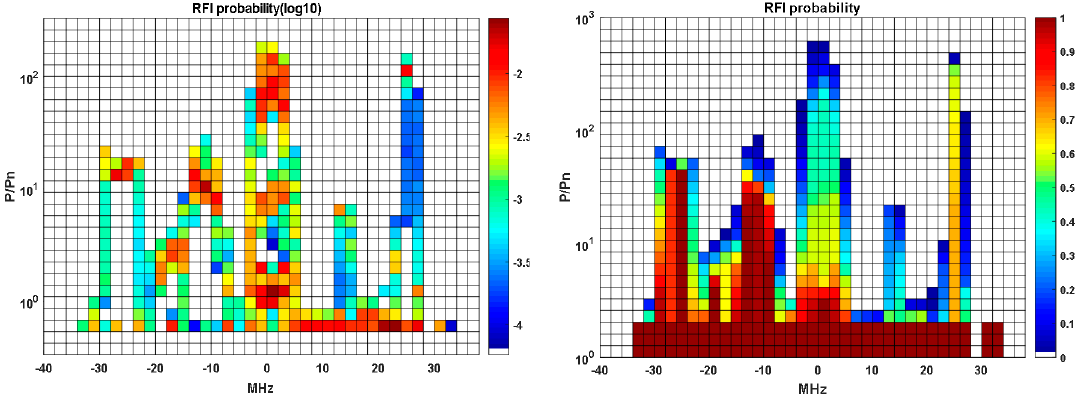
Figure A8. Histograms ( left ) and cumulated histograms ( right ) of RFI power distributions with frequency, normalized to S1 noise estimated by processing data coming from the highest RFI in Figure A6 averaged in different times. Vertical scale is probability in log10 ( left ) and linear ( right ).